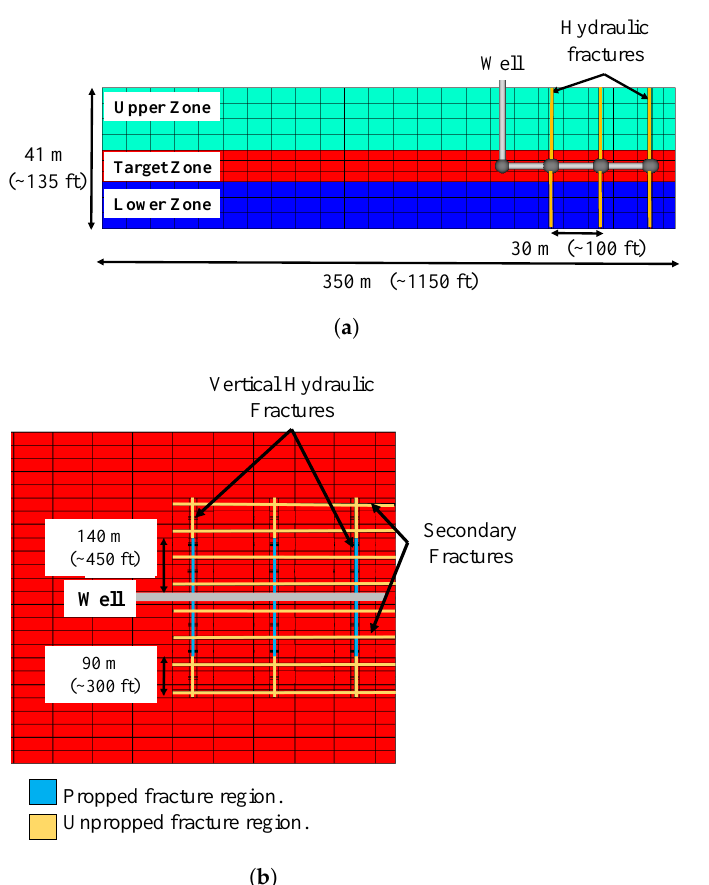
Figure 6. Vertical hydraulic fractures with perpendicular secondary fractures. ( a ) Cross-view of the model along the wellbore and ( b ) map view of the model.